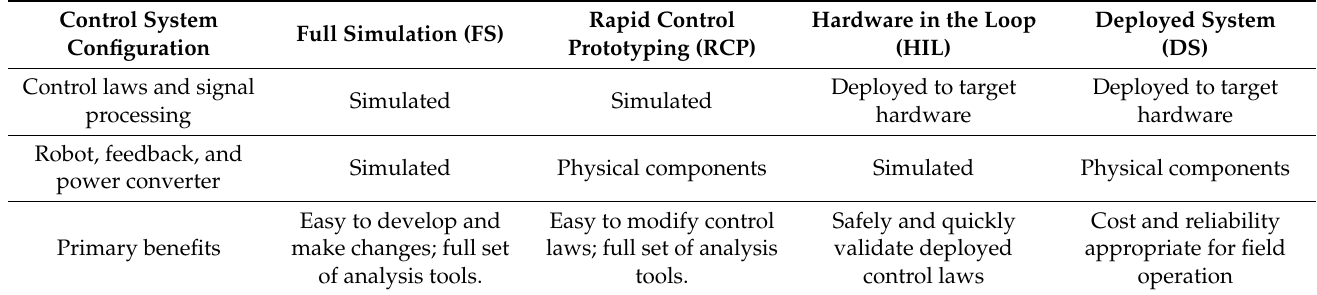
Table 1. Implementation of closed-loop control algorithms.